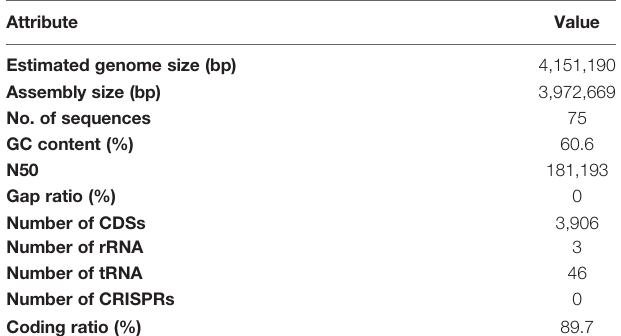
TABLE 1 | Genome statistics for Shimia aestuarii